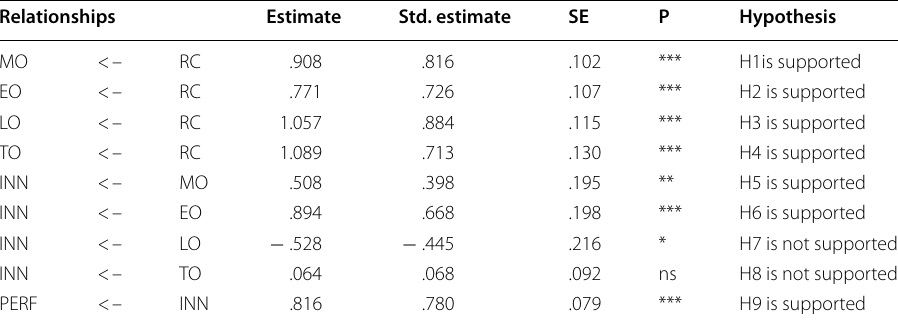
Table 2 Relationship between variables in the proposed model